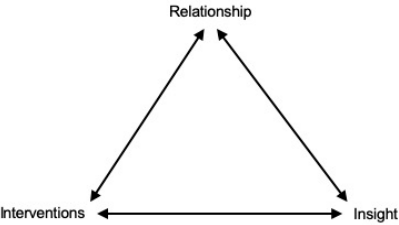
Figure 1. Dynamic interrelationship and synergy between elements of therapy. For example, a single intervention was not only experienced to increase insight, but also to strengthen the rela- tionship. The strengthened relationship could in turn make it easier for the patient to open up and access difficult emotions in therapy. This will further make it possible for the patient to reach new insights, and also make the patient open to new therapeutic interventions. This is an ongoing pro- cess throughout therapy.